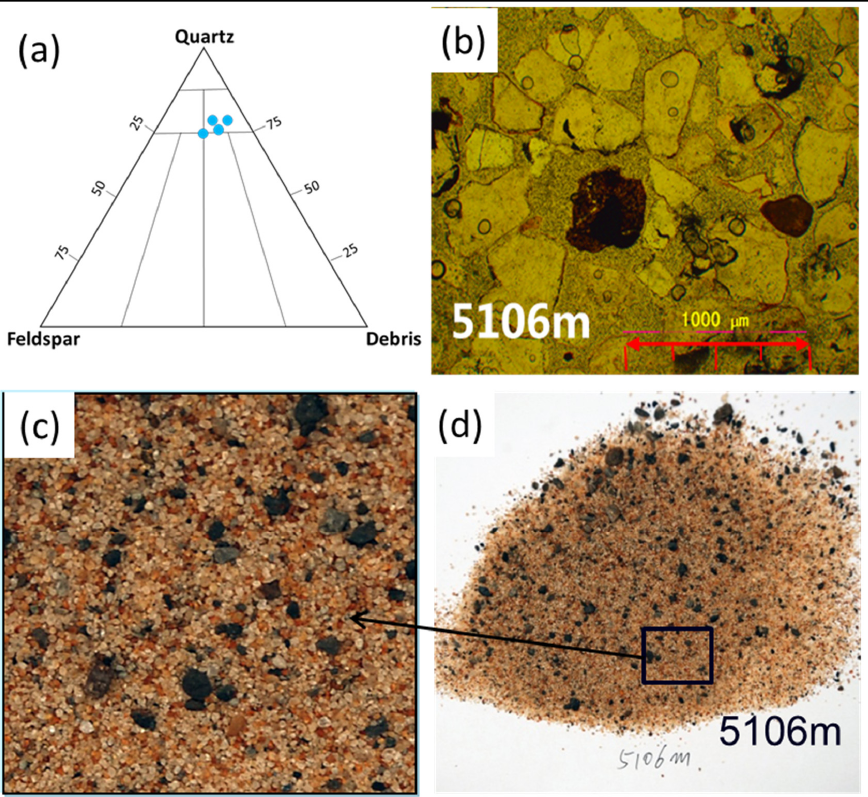
Figure 18. Plots of sandstone classification and pictures of rock thin section analysis in Well C, 5106 m. ( a ) Plots in a triangle of Sandstone classification. ( b ) Analysis of Rock thin section. ( c ) Partial enlarged picture of debris Samples. ( d ) Debris Samples.